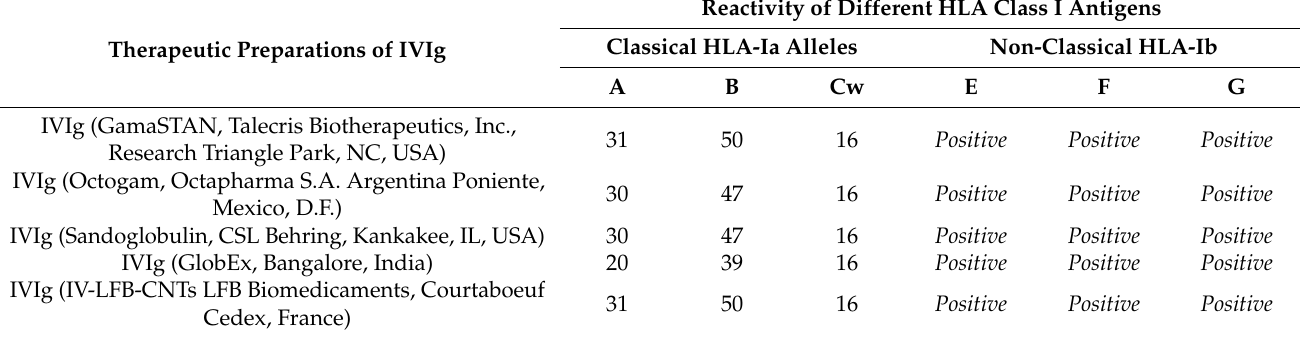
Table 6. HLA-I reactivity of different therapeutic preparations of